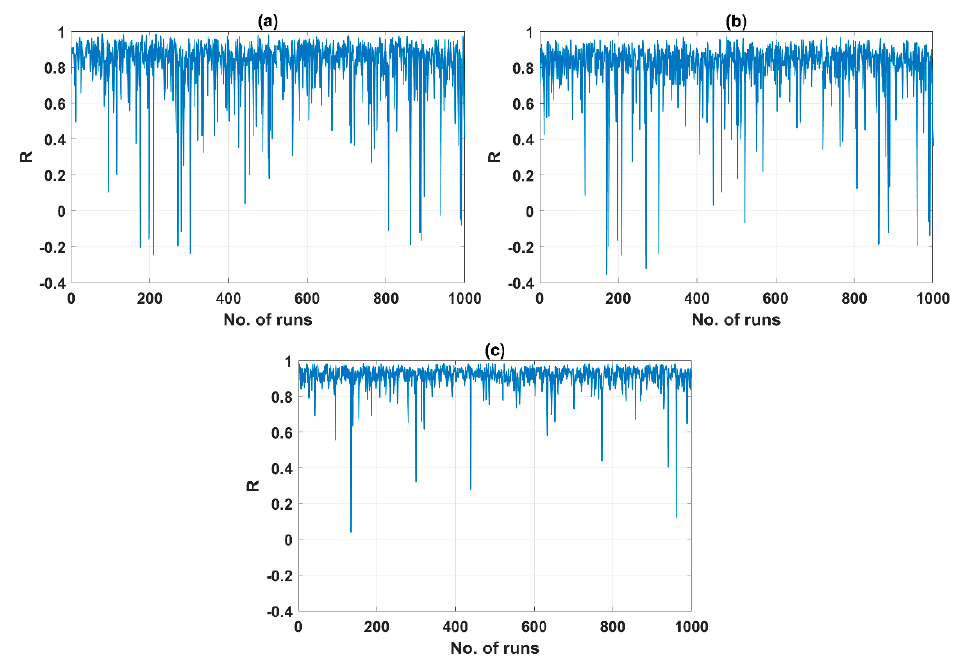
Figure 7. Values of R over 1000 Monte Carlo simulations in case of ( a ) testing PSOANFIS, ( b ) testing GAANFIS and ( c ) testing SVM.